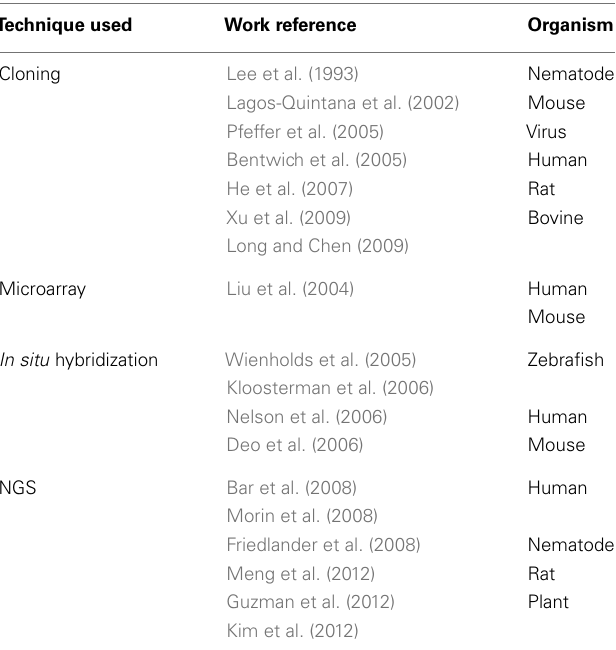
Table 1 | Experimental tools applied to discovery of miRNAs. NGS: next-generation